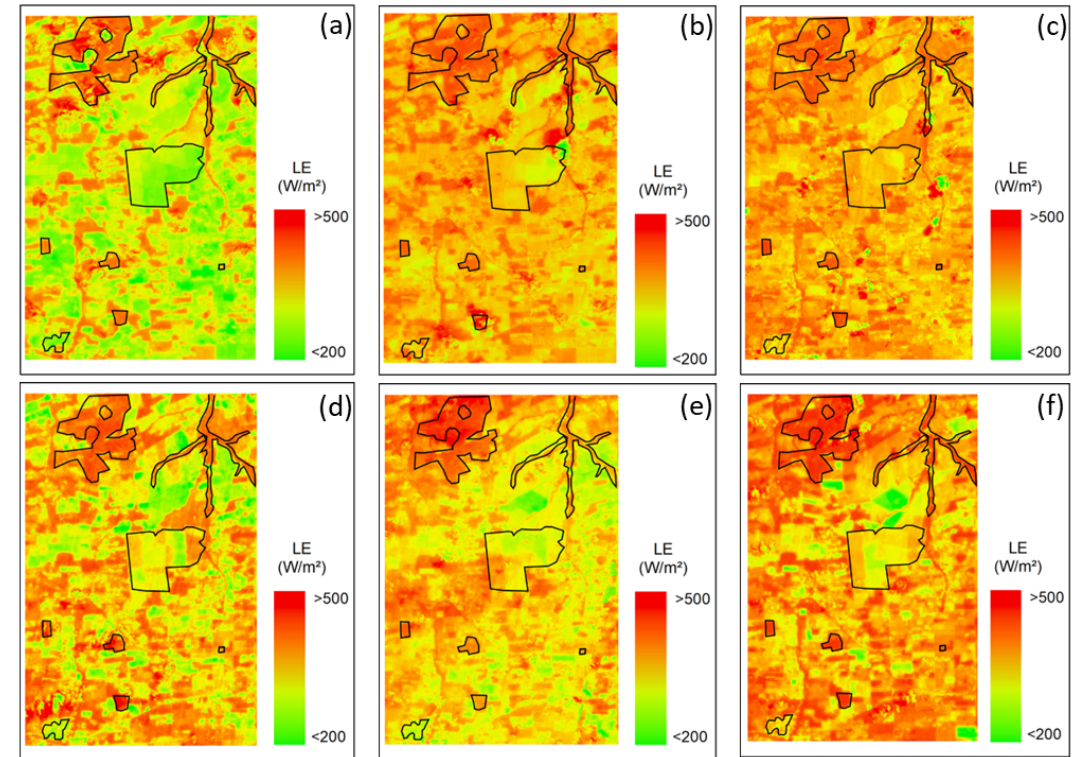
Figure 9. Temporal distribution of latent heat flow (LE) on 20 November 2017 ( a ), 22 December 2017 ( b ), 31 May 2018 ( c ), 7 June 2018 ( d ), 26 June 2019 ( e ), and on 29 August 2019 ( f ).